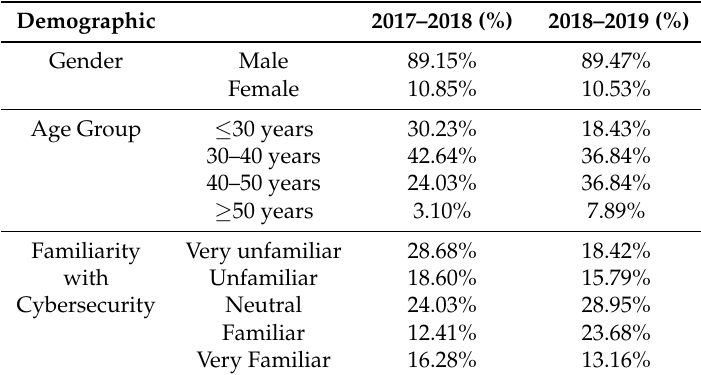
Table 1. Summary of Demographic